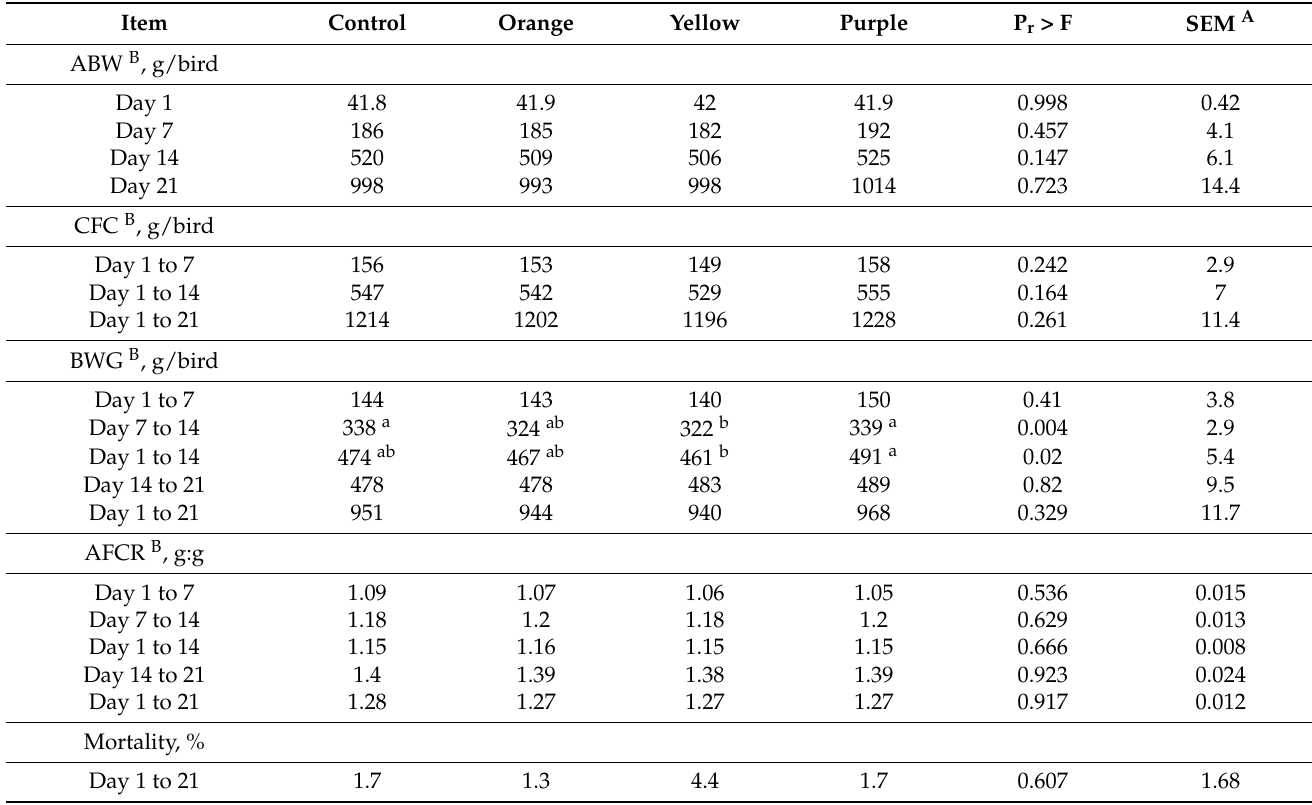
Table 4. Influence of Control (basal diet only), Orange, Yellow, and Purple Feed Colors on Average Body Weight, Cumulative Feed Consumption, Body Weight Gain and Adjusted Feed Conversion Ratio of Broilers from 1 to 21 Days of Age (Least Squares Means) (Trial